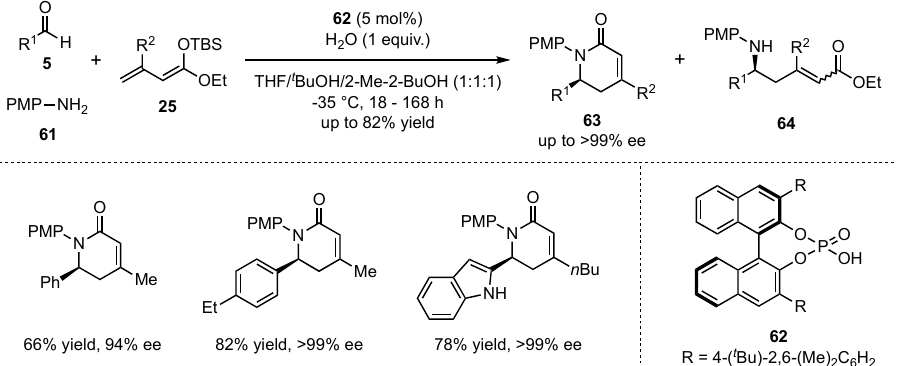
Scheme 17. Formation of aza-Diels–Alder cycloadducts by alternative reaction control in the presence of chiral phosphoric Brønsted acids.